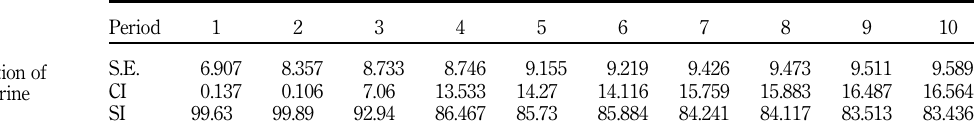
decomposition of China ’ s marine